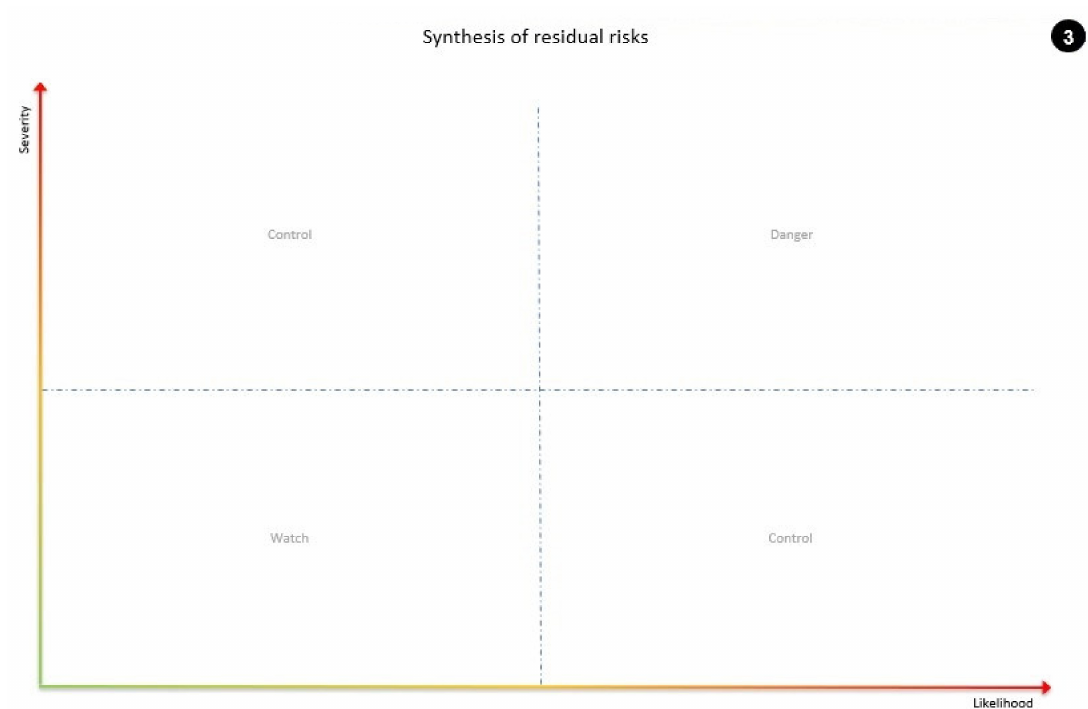
Figure 17. Ob é risk datasheet—workshop n ◦ 5: synthesis of residual risks (template). In the synthesis of residual risks, the filigreed text qualifies the risk level. If a residual risk is positioned in the upper right corner, the filigreed text indicates a danger . If a